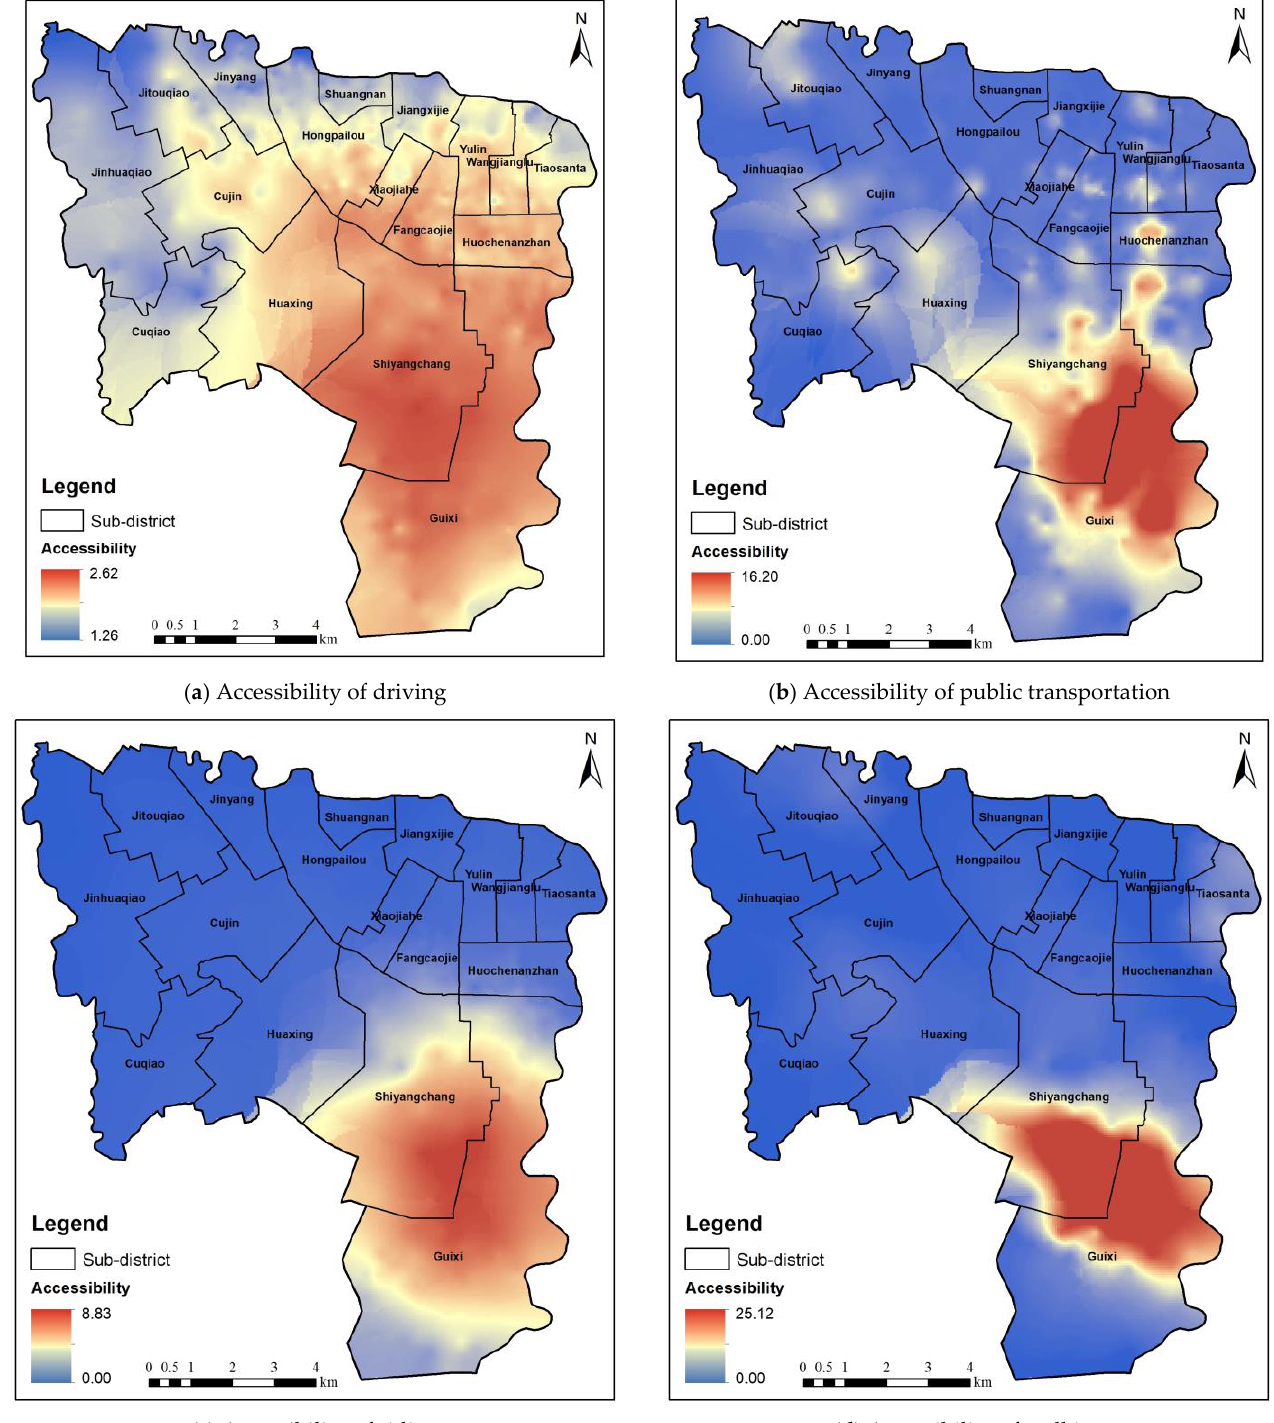
Figure 5. Park accessibility based on supply competition G2SFCA method.